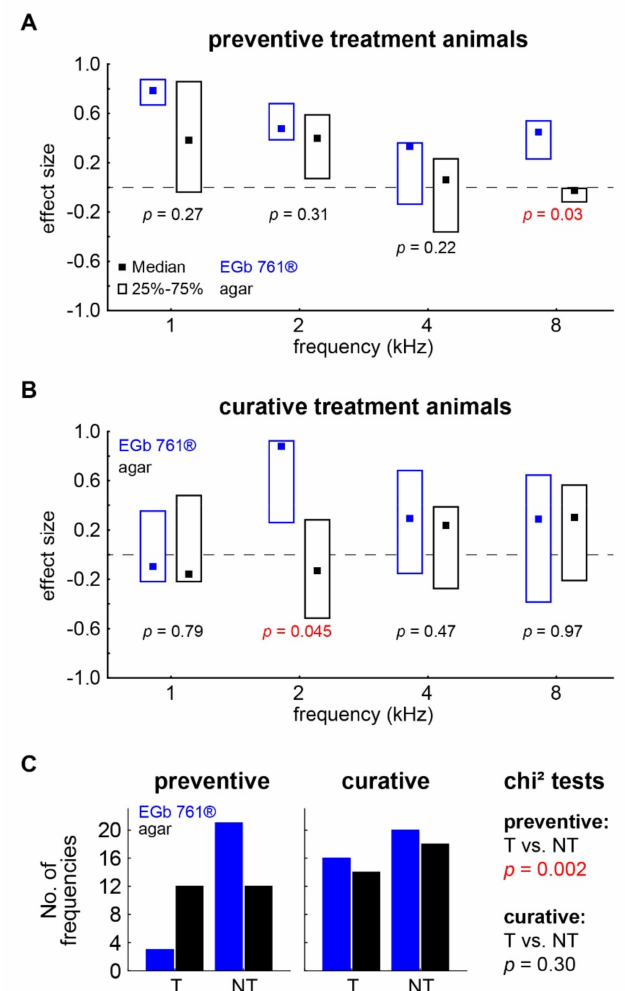
Figure 5. Effect size of GPIAS response change 3 weeks after trauma. ( A ) Median and interquartile ranges of effect size of behavioral response change after preventive treatment in EGb 761 (blue symbols) and agar control animals (black symbols) over the four tested frequencies. The p -values give the results of the independent Mann–Whitney U-tests. ( B ) Median and interquartile ranges of behavioral response change after curative treatment . ( C ) Number of frequencies indicating a tinnitus percept (T; negative effect size) or no tinnitus percept (NT) in EGb 761 and agar control animals of both treatment groups. The results of the independent chi 2 tests T vs. NT are given on the